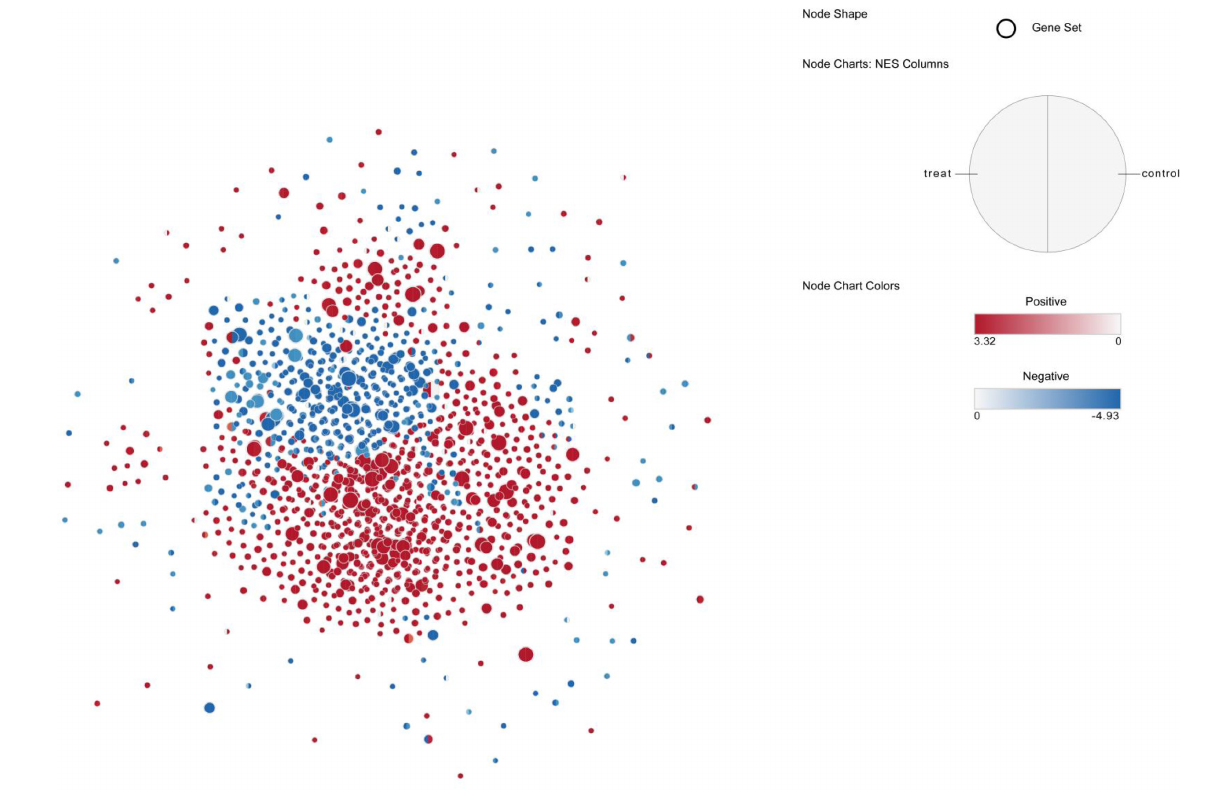
FIGURE 10 | Up-regulated pathway network of blood and skin in control and treat, the red node indicates that the pathway is up-regulated in the skin, and the blue node indicates that the pathway is up-regulated in the blood, the left half of the node represents treat and the right side represents